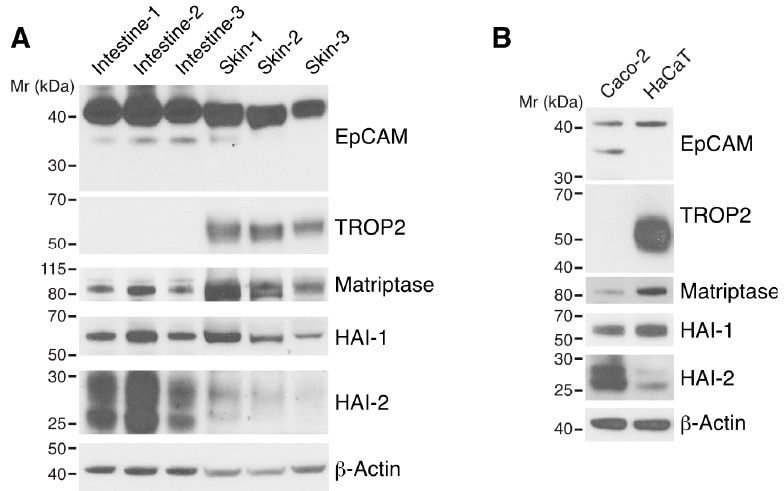
Figure 1. Expression of HAI-1, HAI-2, matriptase, EpCAM, and TROP2 in skin and intestine.